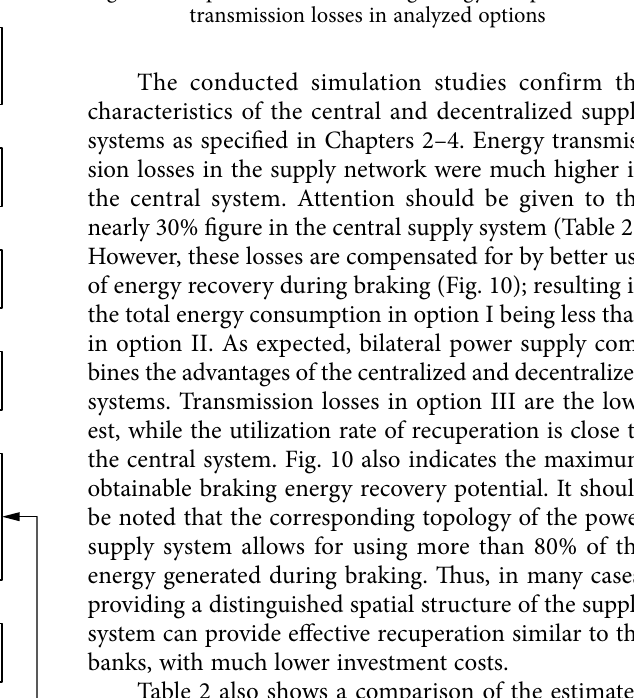
Fig. 10. Comparison of the breaking energy recuperation and